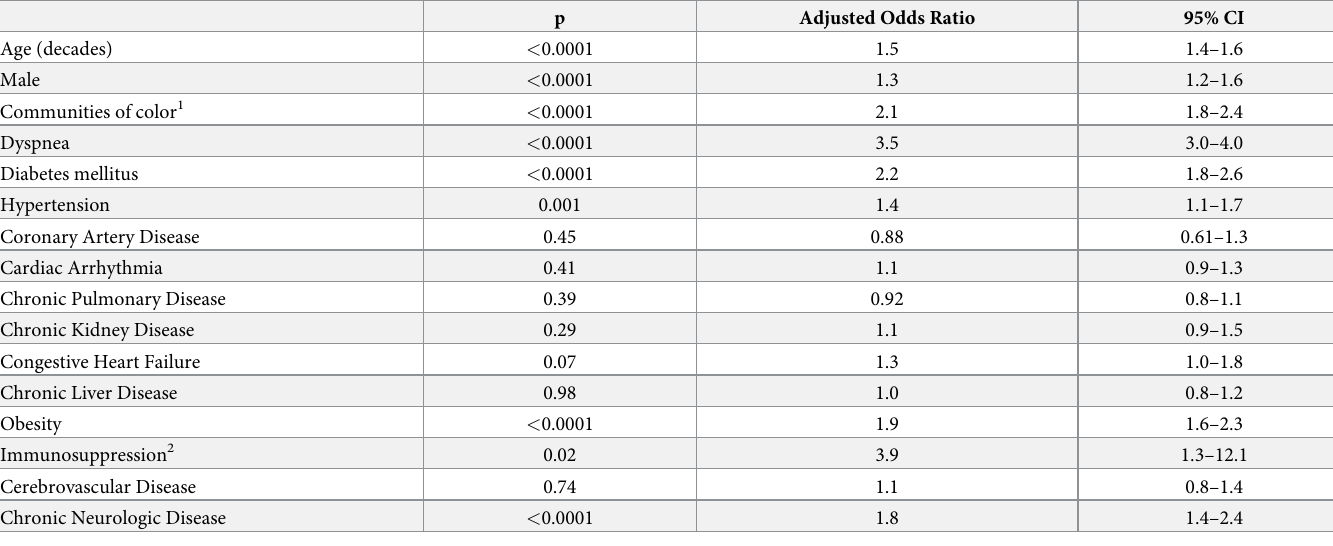
Table 4. Multivariable logistic regression model for hospitalization in the derivation cohort.